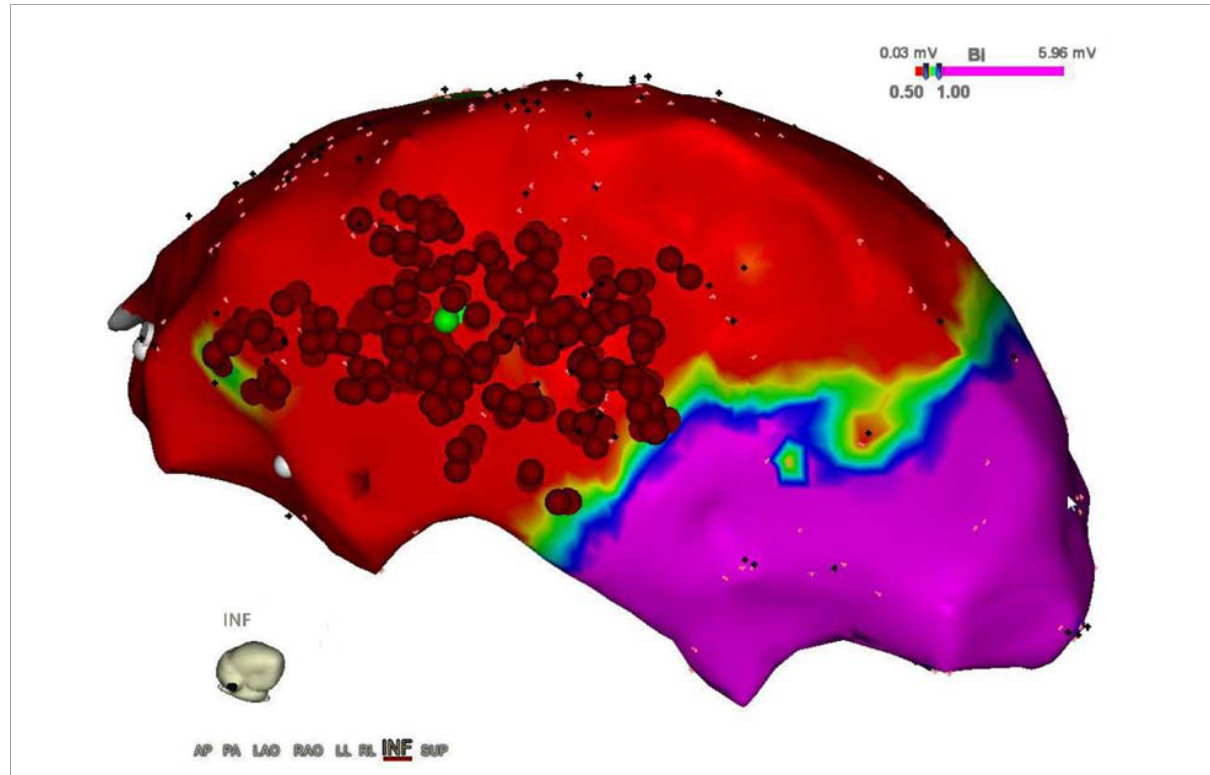
FIGURE1 Epicardial electroanatomic mapping. The picture shows the epicardial electroanatomic mapping of both ventricles from the inferior view: voltages below 0.5 mV (red color) were considered scar and voltages above 1.0 mV were considered normal myocardium (purple color). In between border zone, tissue is colored yellow, green, and blue. Ablation points are represented by the red dots, performed to eliminate ventricular